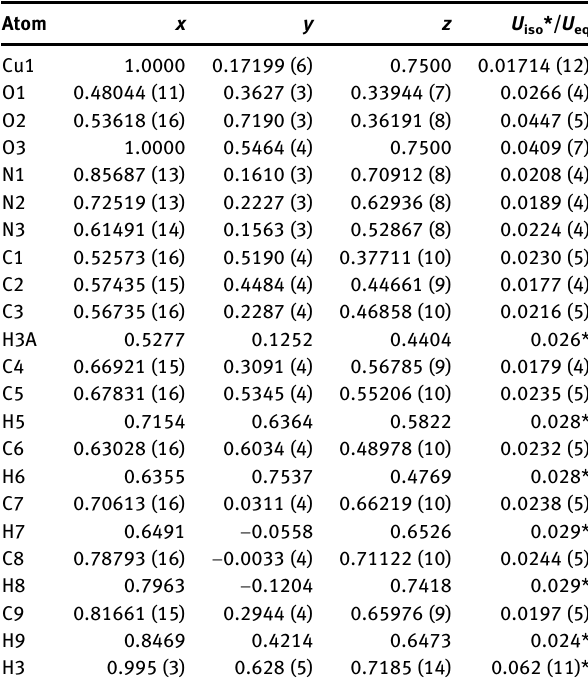
by 6-(1 H -imidazol-1-yl)nicotinate anions to form a 1D chain, with a Cu / Cu separation of 11.1549(4) Å.